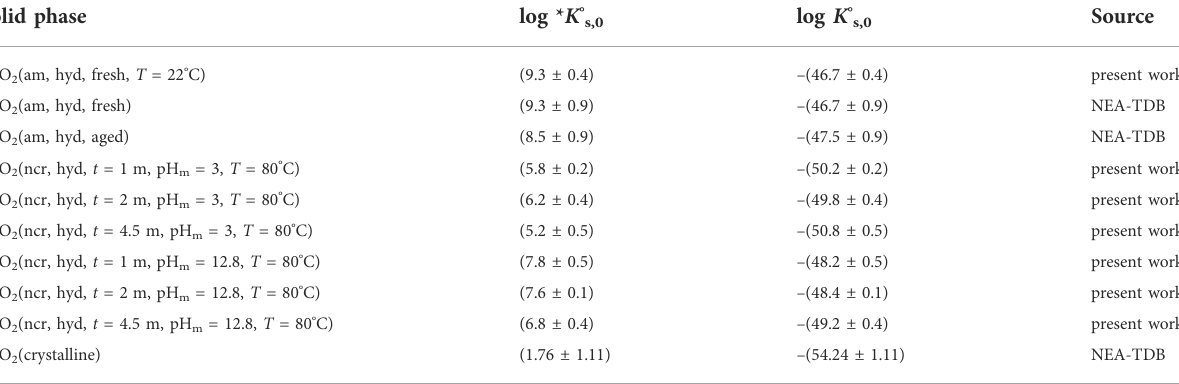
TABLE5SolubilityconstantsforThO 2 (s,hyd)andThO 2 (cr)asdeterminedinthisworkorselectedintheNEA-TDB(Randetal.,2009).Thevaluesoflog *K ° s,0 andlogK ° s,0 correspondtotheequilibriumreactionsThO 2 · nH 2 O(s)+4 H + 5 Th 4+ +(2+ n )H 2 O(l)andThO 2 · nH 2 O(s)+(2 – n)H 2 O(l) 5 Th 4+ + 4 OH − ,